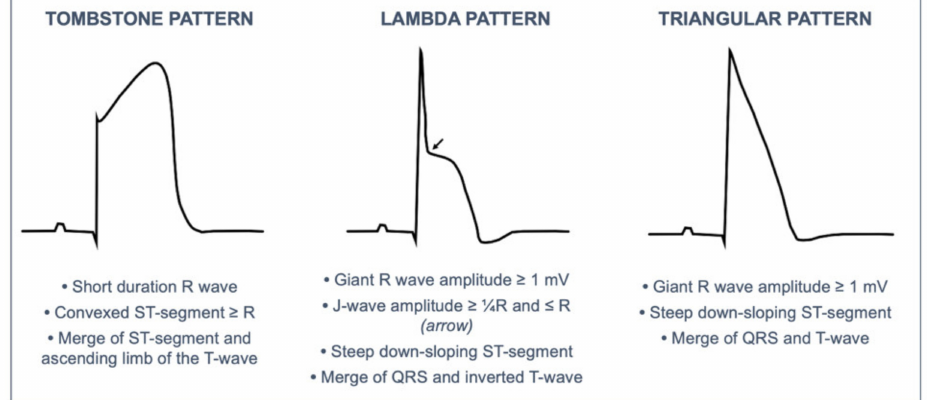
Figure 1. Definition of the electrocardiographic STEMI pattern analyzed in the